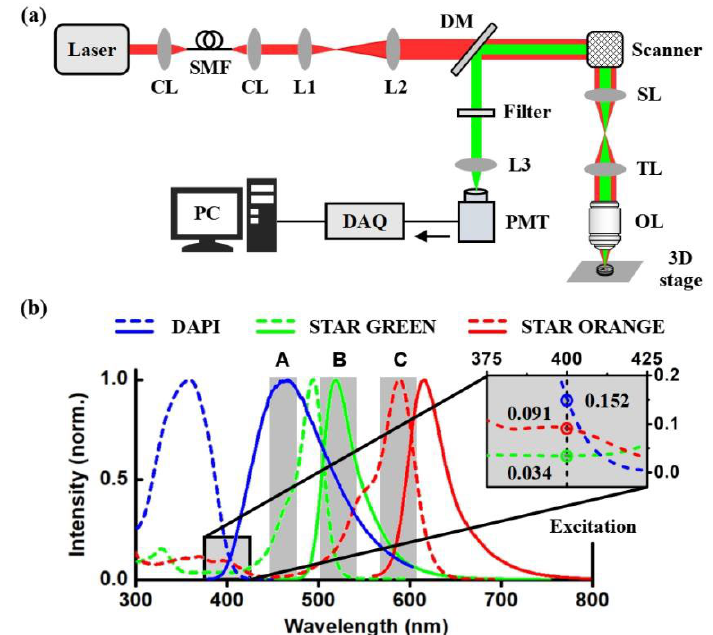
Figure 1. ( a ) Schematic of TPM. CL, collimating lens; SMF: single-mode fiber; L: lens; DM: dichroic mirror; SL: scan lens; TL: tube lens; OL: objective lens; PMT: photomultiplier tube; DAQ: data acquisition card. ( b ) The principle of the signals separation strategy. The dashed and solid lines represent the absorption and emission spectra of the fluorescent probes, respectively.